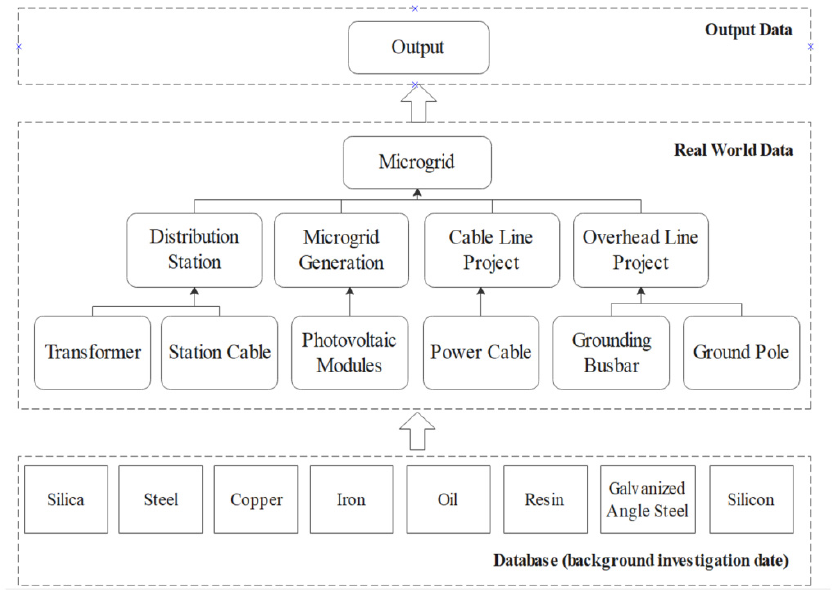
Figure 6. System boundary of the microgrid.